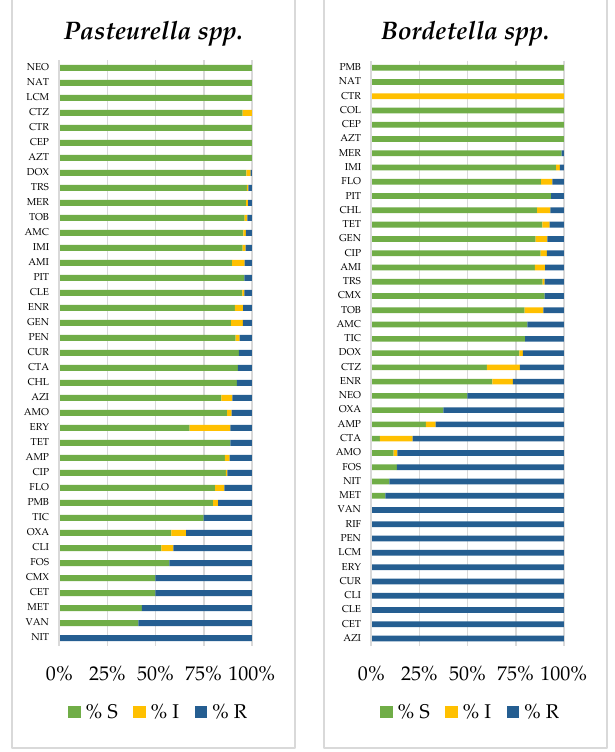
Figure A3. Proportion of susceptible (S), susceptible—increased exposure (I), and resistance (R) bacterial strains in mammals.